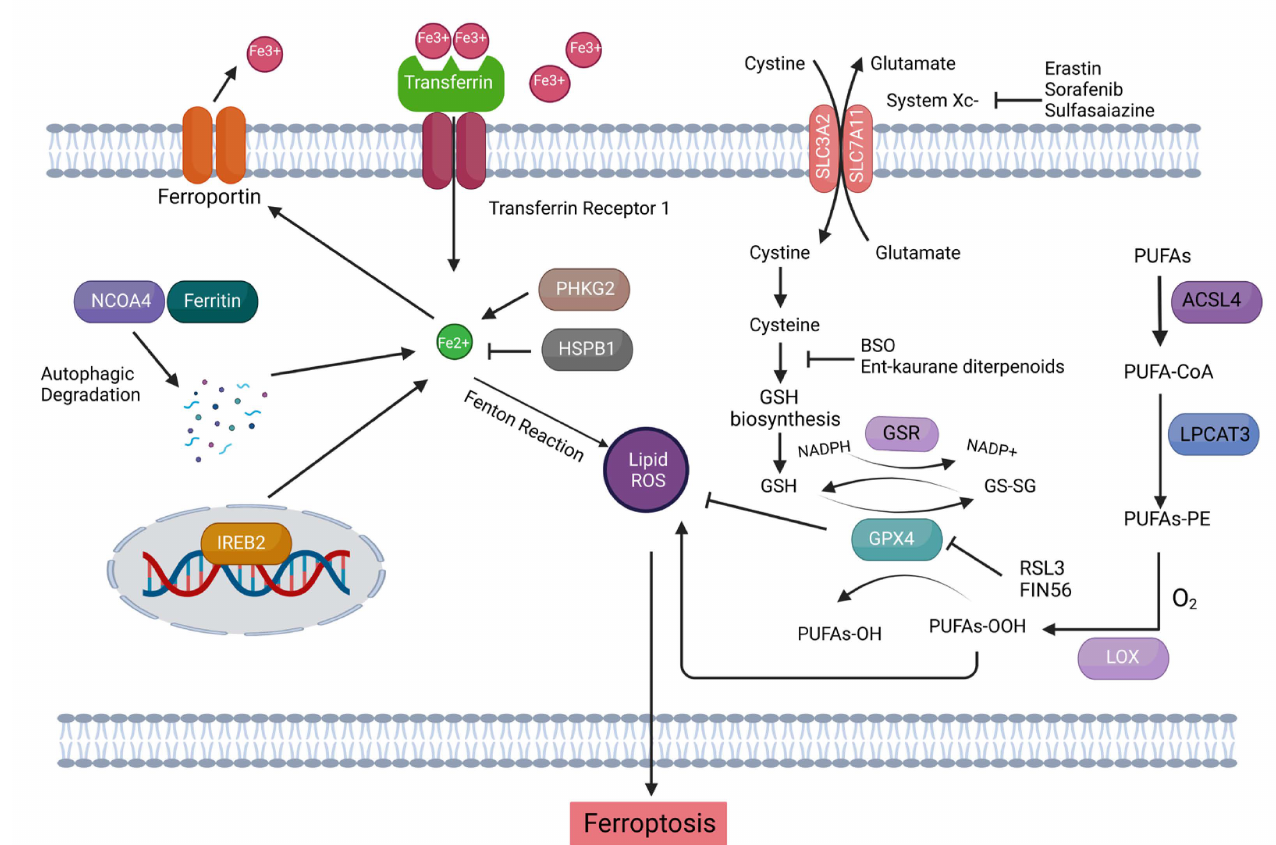
Figure 3. The mechanisms of ferroptosis. Ferroptosis is induced through inhibition of system Xc- or Glutathione Peroxidase 4 (GPX4) activity, ultimately resulting in cell death. System Xc-, a cystine/glutamate antiporter, transports intracellular glutamate to the extracellular space in exchange for the extracellular cystine into the cell, which is subsequently transformed into cysteine (Cys2), a reduced form of cystine, for the synthesis of glutathione (GSH). Exploiting GSH as the cofactor, GPX4 exerts its phospholipid peroxidase activity to prevent the accumulation of lipid reactive oxygen species (ROS) within the cell by reducing the endogenous lipid peroxides from PUFAs-OOH to PUFAs-OH. Therefore, the small molecule inhibitors, such as Erastin and Sorafenib, -mediated inhibition of system Xc- causes depletion of GSH and inactivates GPX4 that eventually leading to the accumulation of lethal lipid peroxides and the initiation of ferroptosis. In addition, direct inhibition of GPX4 through inhibiting its activity, e.g., ferroptosis inducer (1S, 3R)-RSL3, or promoting its degradation, e.g., genetic knockout of GPX4 is another way of ferroptosis execution. Besides lipid peroxidation, the excessive number of irons is also an essential criterion for ferroptosis induction. Circulated iron was combined with transferrin (TF), an iron-binding protein, in the form of ferric ions (Fe 3+ ) and transported into cells by TFR1-mediated endocytosis. Ferric ions were deoxidized to ferrous ions (Fe 2+ ) by iron oxide reductase STEAP3, which then are capable of catalyzing lipid peroxides to form damaging free radicals via Fenton Chemistry. When these lipid peroxides cannot be eliminated in time within the cell, ferroptosis may occur